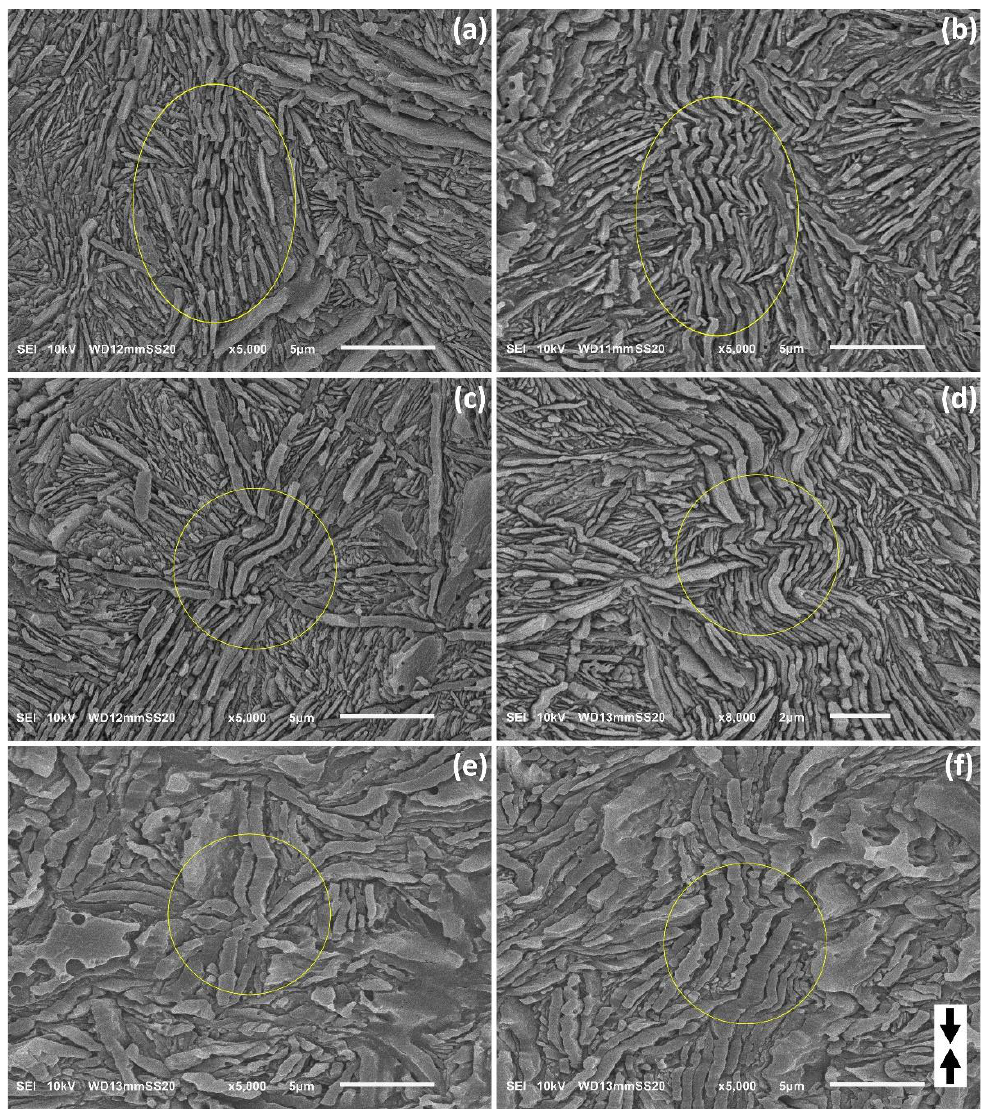
Figure 8. SEM micrographs of the samples H3-CE ( a – d ) and H4-CE ( e , f ) deformed by uniaxial compression, illustrating the microbuckling and early stages of kinking. The direction of compression is vertical in all micrographs. The true strain applied was: e = 0.2 ( a ), 0.4 ( b ), 0.4 ( c ), 0.7 ( d ), 0.5 ( e ), 0.5 ( f ). The observation plane was exposed by microtoming followed by permanganic etching. Areas of interest discussed in the text are marked with yellow circles.